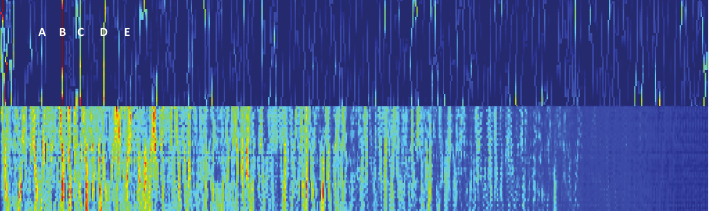
Figure 2. An example for LOFAR and DEMON spectrum in low-speed rotation (“Hailangdao" ship, 600 r min − 1 ), with upper for LOFAR and lower for DEMON. Letter annotations are used to illustrate · the harmonic relationship between spectral lines. The vertical axis represents time and the horizontal axis